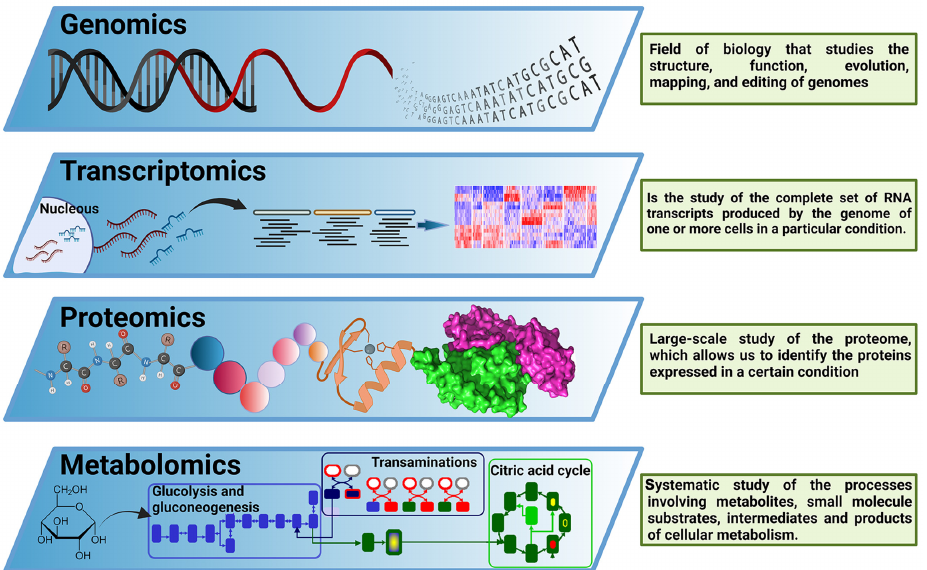
Figure 2. The central dogma of − omics technologies. Overview of − omics methodological ap- proaches most relevant for biological and biomedical research. These include genomics, tran- scriptomics, proteomics, and metabolomics, covering the main components of the Central Dogma of M olecular B iology. This figure was created using BioRender.com. (Meta)-transcriptomics is the analysis of RNA molecules, such as messenger RNA (mRNA), ribosomal RNA (rRNA), transfer RNA (tRNA), and other non-coding RNAs produced by an organism, population of organisms, or product of the interaction between organisms and the environment [27]. (Meta)-proteomics is the analysis of proteins pro- duced by an organism or population of organisms and their function; and finally, metab- olomics refers to the complete set of small chemical compounds, such as metabolic inter- mediates, hormones, secondary metabolites, and other signaling molecules to be found within a biological sample [28]. All these technologies have revolutionized and positively impacted biological sci- ences since they allow an increase in the non-targeted simultaneous detection, quantifica- tion, and monitoring of a large number of molecules present in a specific sample, optimiz- ing the functional evaluation of the different biological systems. Some of those impacts have been observed in the field of P. gingivalis research, accumulating several studies in metagenomics, deep amplicon sequencing (sometimes miscalled as metagenomics), tran- scriptomics, proteomics, and metabolomics, as well as their -meta counterparts (Figure 3, Tables 1–3).